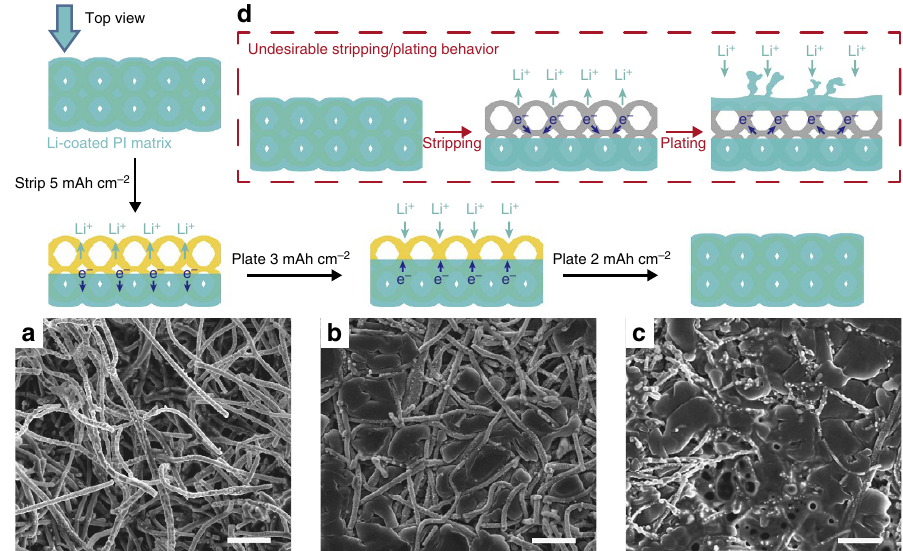
Figure 3 | Well-confined stripping/plating behaviour of the Li-coated PI matrix. Top-view SEM images of ( a ) the exposed top fibres of the Li-coated PI electrode after stripping away 5mAhcm (cid:2) 2 Li; ( b ) exposed top fibres partially filled with Li when plating 3mAhcm (cid:2) 2 Li back and ( c ) completely filled PI matrix after plating an additional 2mAhcm (cid:2) 2 Li back (current density 1mAcm (cid:2) 2 , in EC/DEC). The polymeric matrix ensures that Li is dissolved and deposited from the underlying conductive Li substrate and, as a result, Li is effectively confined into the matrix. ( d ) Schematic illustrating the alternative undesirable Li stripping/plating behaviour where, after stripping, Li nucleate on the top surface, leading to volume change and dendrites shooting out of the matrix. Scale bars, 5 m m.